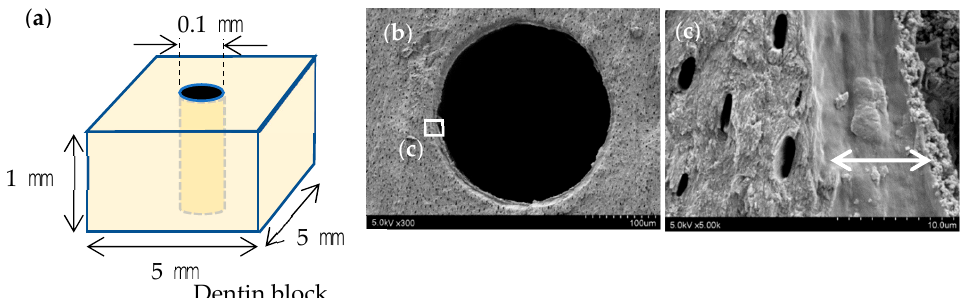
Figure 1. Preparation of simulated root canals. ( a ) Perforation of the dentine block with a diameter of 0.1 mm ( b ) SEM image of the fractured simulated root canal after decalcification. ( c ) Decalcified layer measuring approximately 10 µm in its dry condition (arrows).